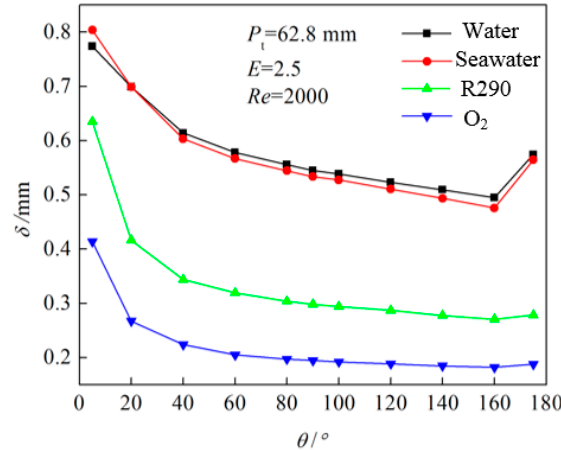
Figure 16. Local film thickness δ on the elliptical tube.